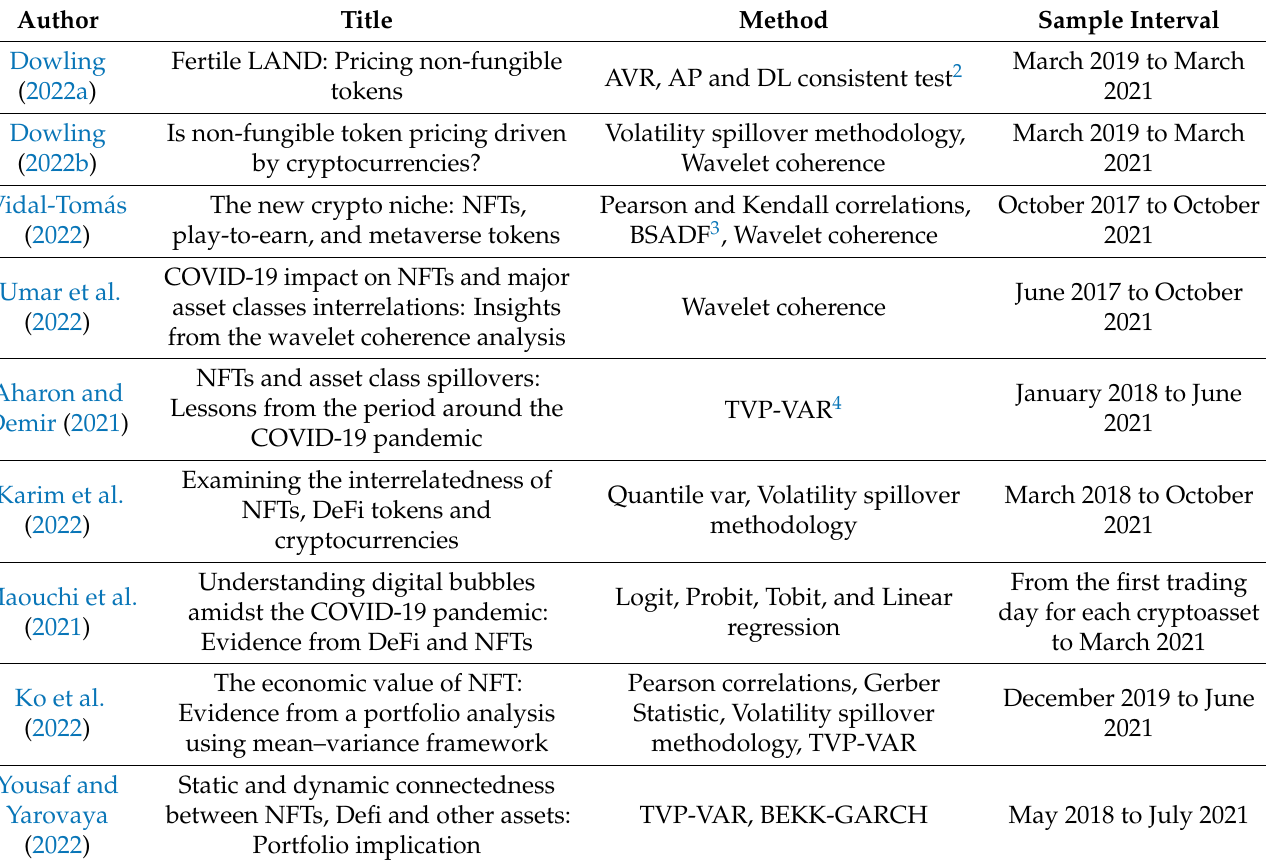
Table 2. Content analysis of empirical literature